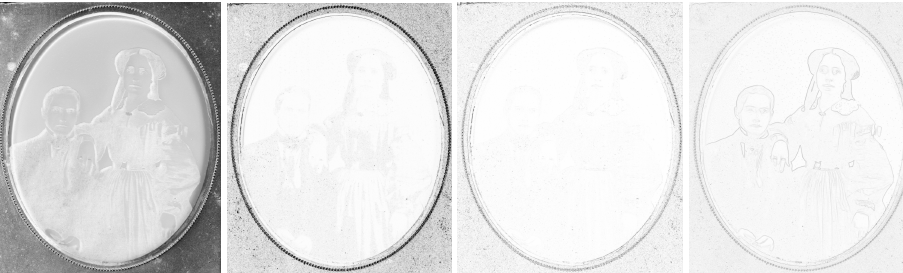
Figure 14. Difference images of ambrotype between LLa mode and LRFB reference mode. Left to right: difference image, SSIM map, ESSIM map, filtered edges of the image scanned in LLa mode.